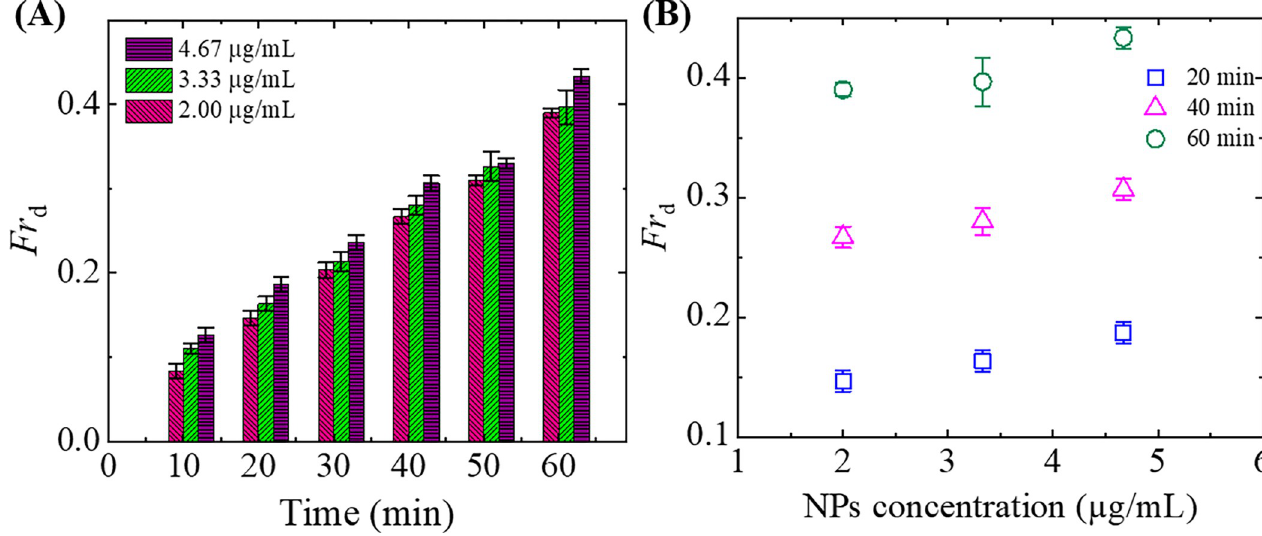
Fig 3. Fraction of deformed 40%DOPG/60%DOPC-GUVs under various NPs concentrations at 50 mM sugar. (A) The bar diagram of Fr d for 2.00, 3.33 and 4.67 μ g/mL NPs. (B) The linear proportionality between NPs concentration and Fr d at different times. The average values with standard deviations were obtained from 3 independent experiments containing 15–20 GUVs in each independent